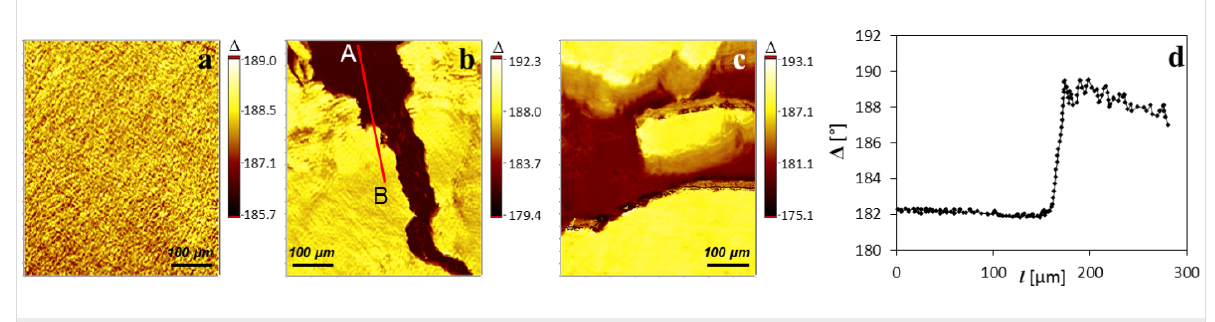
Figure 3: (a–c) Maps of the ellipsometric angle, Δ , recorded on water at room temperature. (a) Represents Δ -values for a closely packed PPDL-D4 film at 10 mN·m − 1 . (b) Recorded before the film was closed by compression and (c) after the film rupture due to stress release. (d) Represents the cross-section trace that can be seen in (b) as red line (A and B indicate the start and end of the